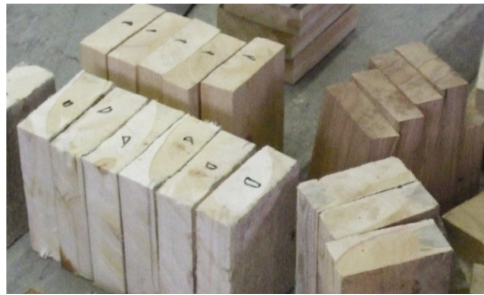
Fig. 5. Wood samples used for the research